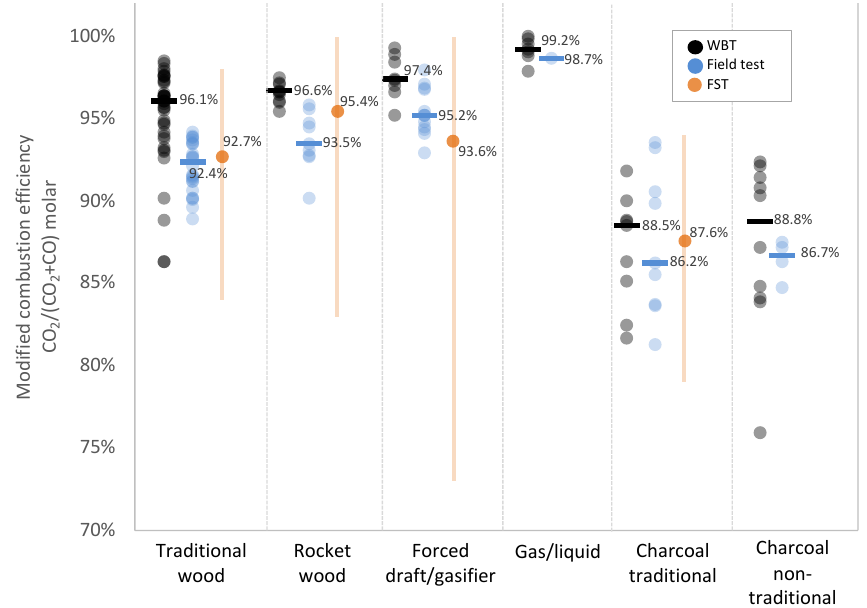
Figure 3. Comparison of modified combustion efficiencies for different stove and fuel types measured from laboratory and field tests. Each data point represents the mean of a set of tests for a given stove fuel / combination, and the rectangles are the median of those data points. The error bars for the firepower sweep test (FST) represent the range of mean modified combustion efficiencies (MCEs) across the test sequences for each respective stove type. Data sources: this study and Roden et al. [9], Jetter et al.